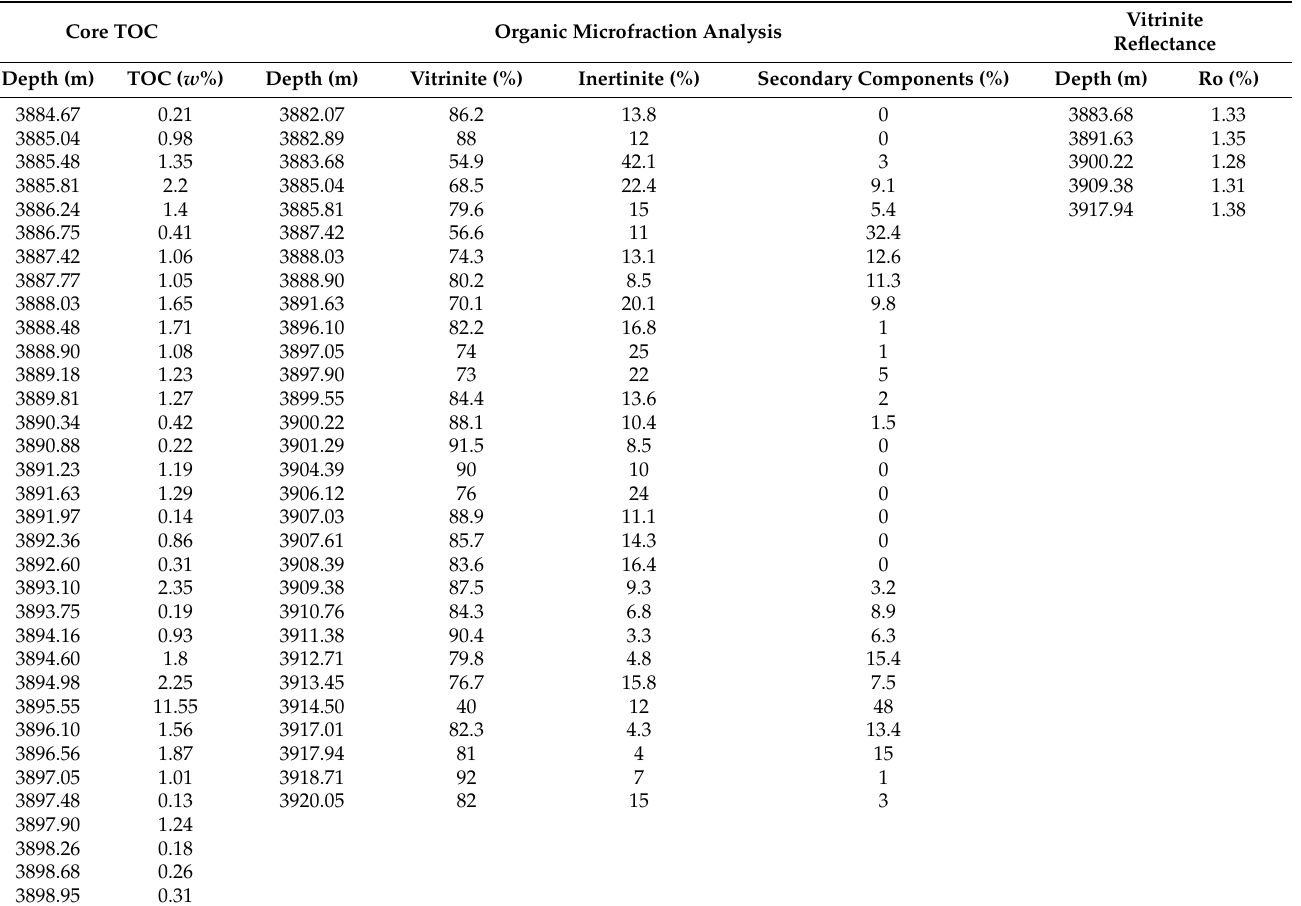
Table 1. Core experimental data of well